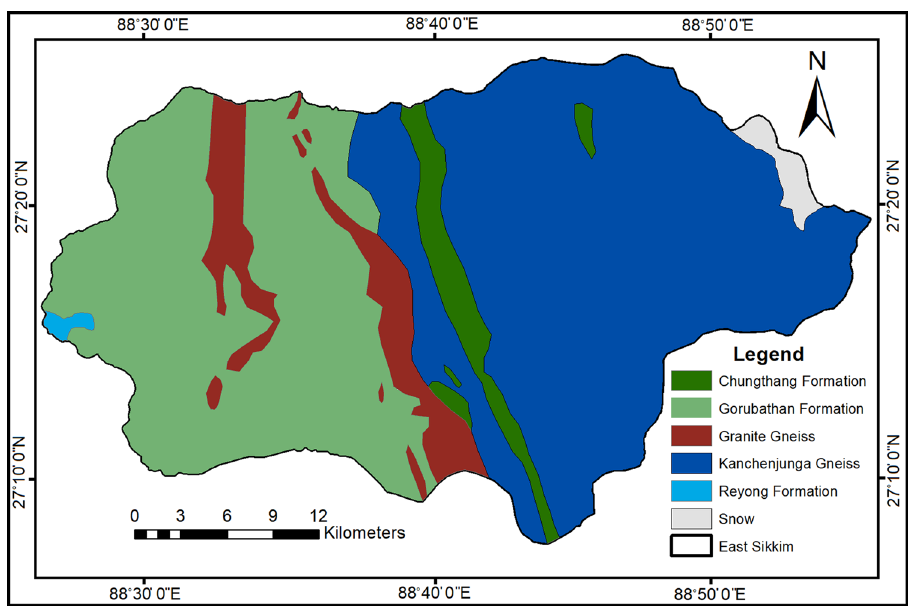
Fig. 3 Geological map of East